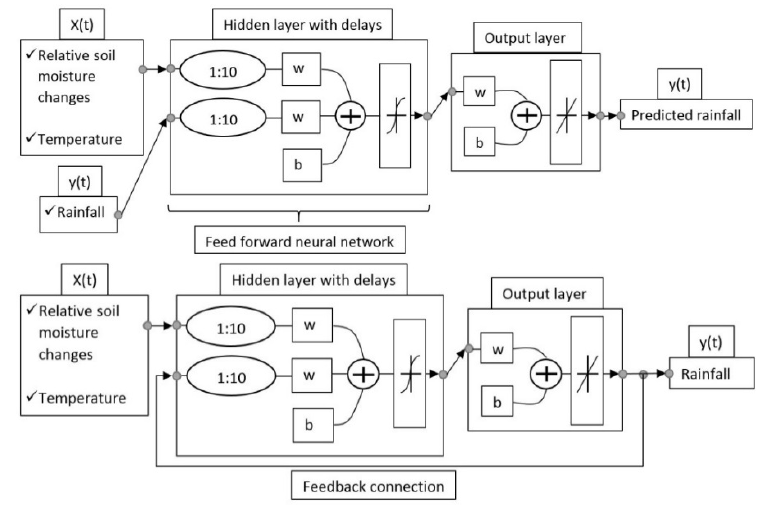
Figure 2. Recurrent neural model (nonlinear autoregressive network with exogenous inputs (NARX) network in open-loop ( upper panel ) and closed-loop ( lower panel ) architecture according to Beale et al., 2012, with an example of d = 10 delays).